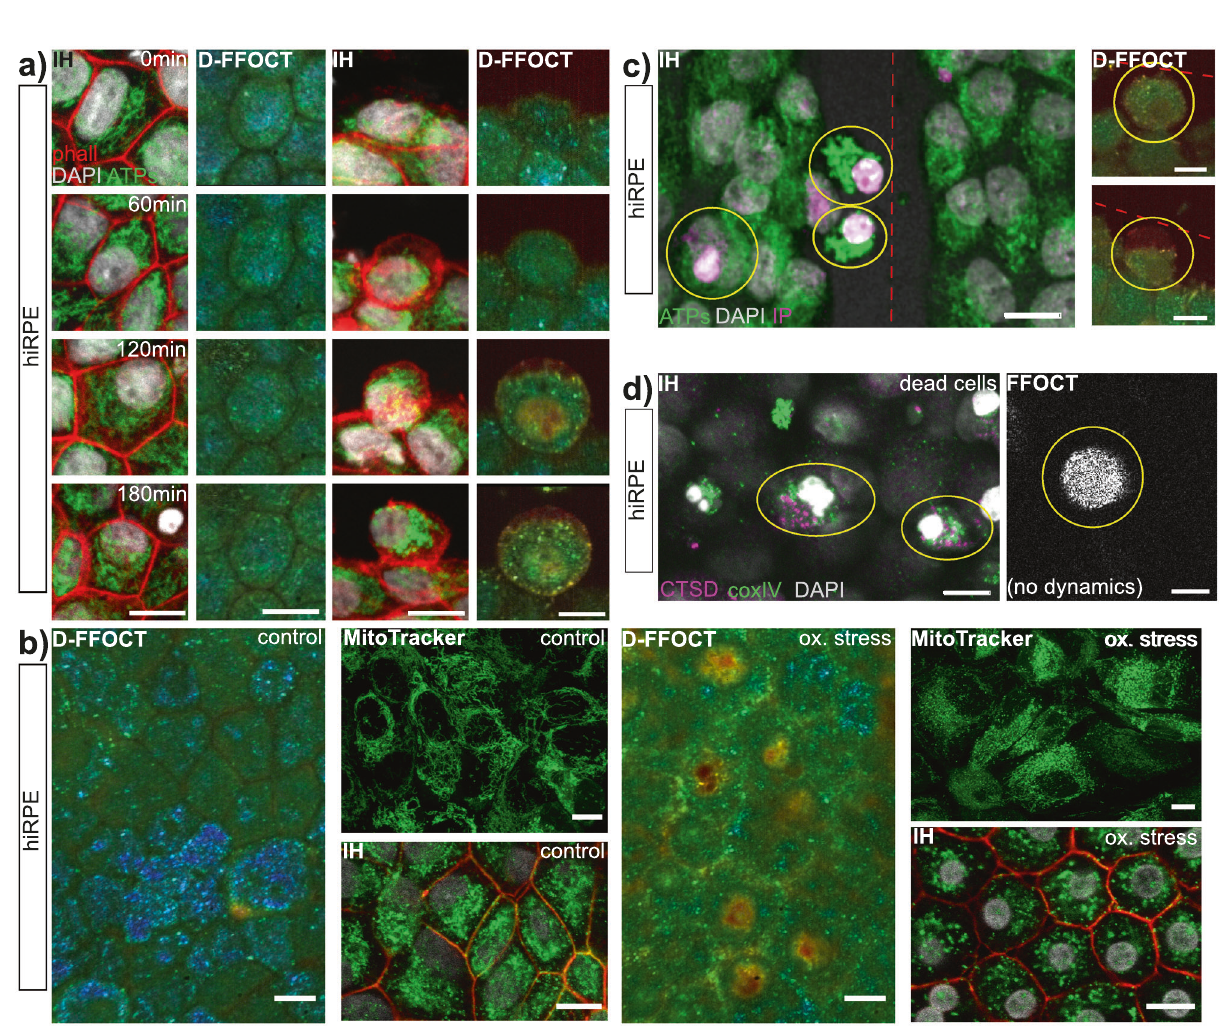
Fig. 4 Cell phenotypes. Nuclei were labelled with DAPI. Red dashed lines show the scratch direction. a Mitochondria phenotype evolution over 3 h. The two left columns show the evolution of a normal cell, with a constant phenotype. The two right columns present the evolution of a stressed cell, with changes in mitochondria aspect (IH) and in dynamic pro fi le (D-FFOCT). b Mitochondria phenotype evolution following an oxidative stress. The left three images show control samples in dynamic pro fi le (D-FFOCT) and both IH (ATPs staining) and live fl uorescence imaging (Mitotracker). The right three images show samples after oxidative stress with the same imaging methods. The D-FFOCT image shows a brighter and faster dynamic pro fi le after stress (i.e., red in the nuclei, green to yellow in the cytoplasm, in addition to the pigment (blue) seen in both control and stress cases). Both IH and Mitotracker show fragmented mitochondria. c Dying cells (circled in yellow) 2 h after the scratch, labelled with propidium iodide (IP in magenta), showing a condensed nucleus. Mitochondria are labelled with ATPs (green). Corresponding cells in D-FFOCT on the right. d Dead cells (circled in yellow) fl oating over the cell culture. Lysosomes labelled with CTSD (magenta), mitochondria with coxIV (green) in IH. Corresponding cells do not exhibit any dynamic signal and are only visible in static (structural not functional) FFOCT. IH immunohistochemistry (scale-bar: 10 μ show the control cultures. The D-FFOCT image shows a uniform cultures after 4 h of oxidative stress. The cells present in the cell layer exhibiting a blue-green dynamic signal. Both immuno- D-FFOCT image show changes in the dynamic pro fi le: the cells histochemistry and MitoTracker images show mitochondria are green to yellow and brighter while the nuclei appear bright organised in a network, meaning no stress is visible in the cells. and red (i.e., larger and faster subcellular movements), indicating The last three images show the results on a parallel set of cell that the cells are undergoing stress. Small bright dots are also